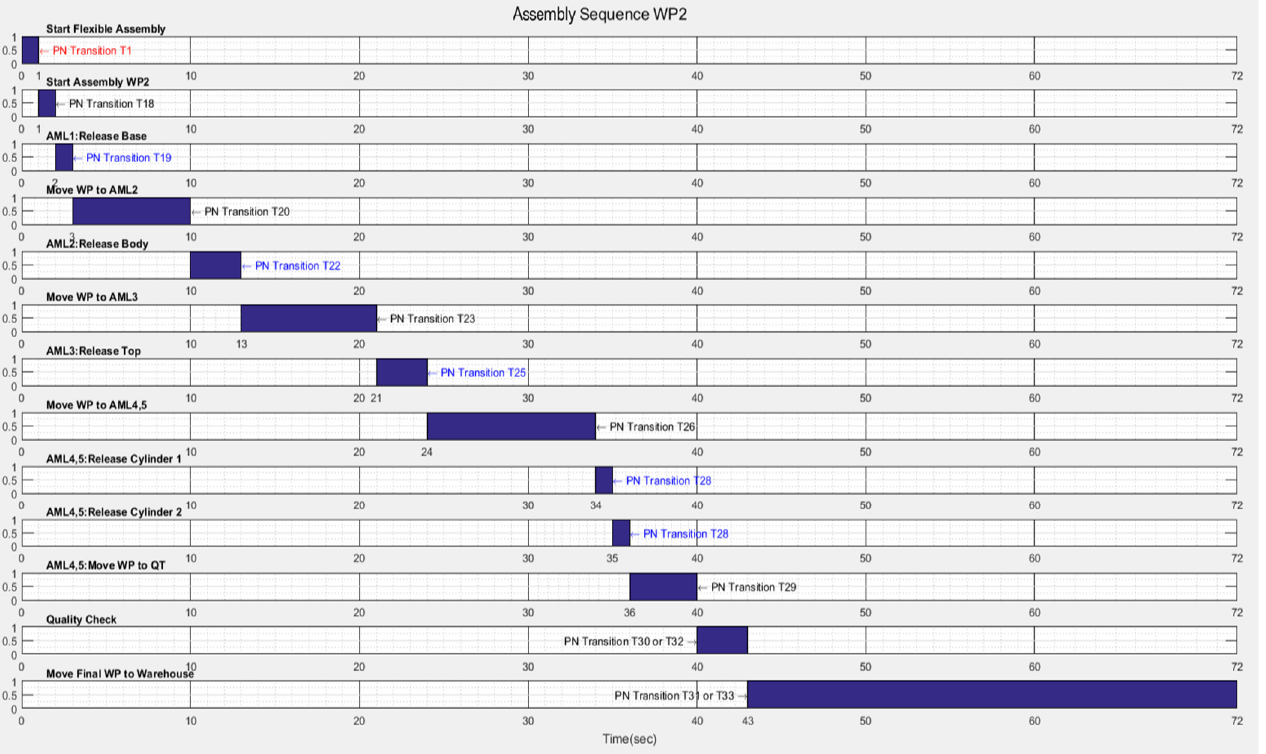
Figure 25. Results for continuous and discrete places associated with displacements of FC with IRM for Assembly WP1.